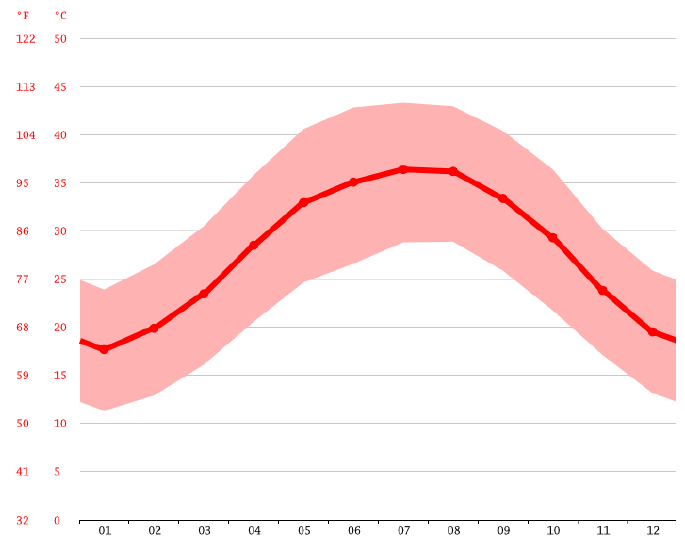
Figure 7. Temperature levels in Al Ain.